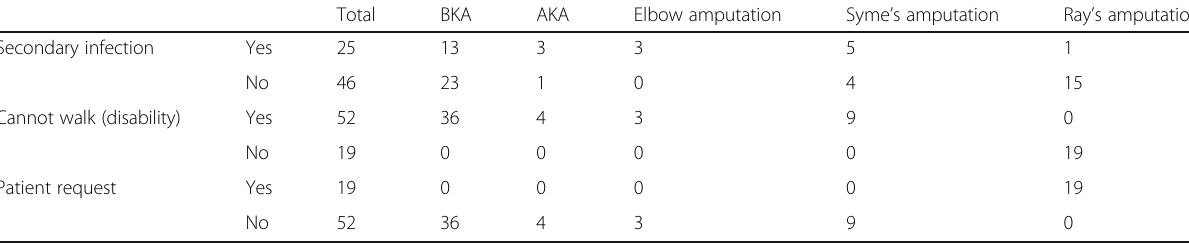
Table 3 Factors associated with types of amputations ( N =